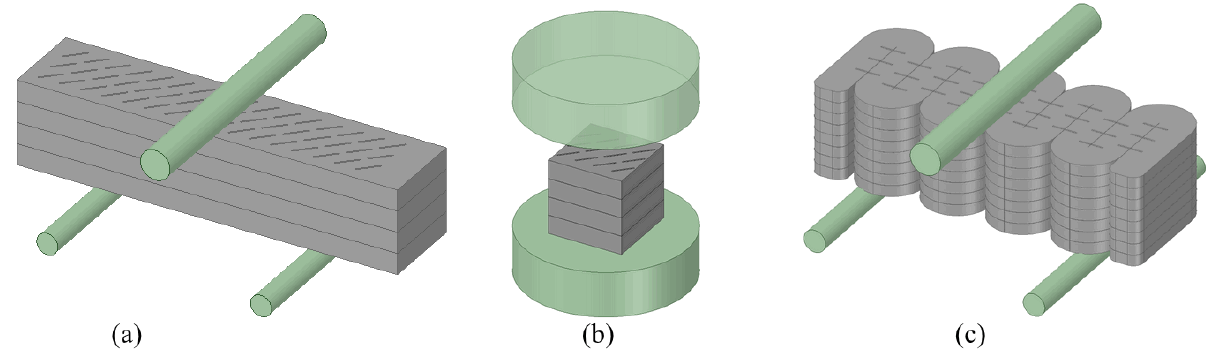
Figure 7. Mechanical tests: ( a ) three-point bending for IR- samples along the Z -axis, ( b ) compressive test for IR- samples loading along the Z -axis, and ( c ) three-point bending for IL- samples.